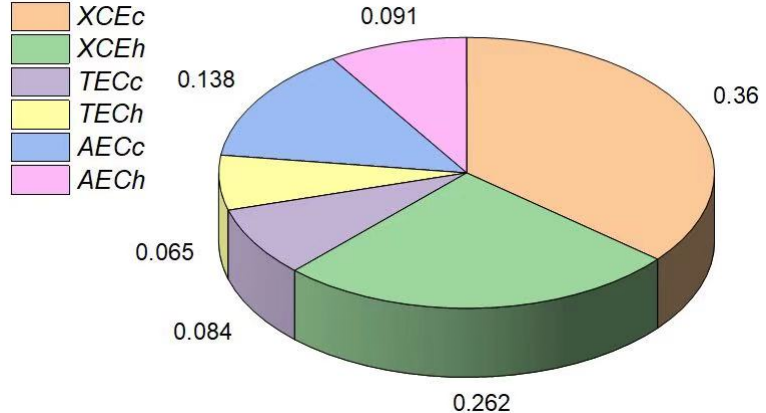
Figure 4. Weight factors of the computable indices.